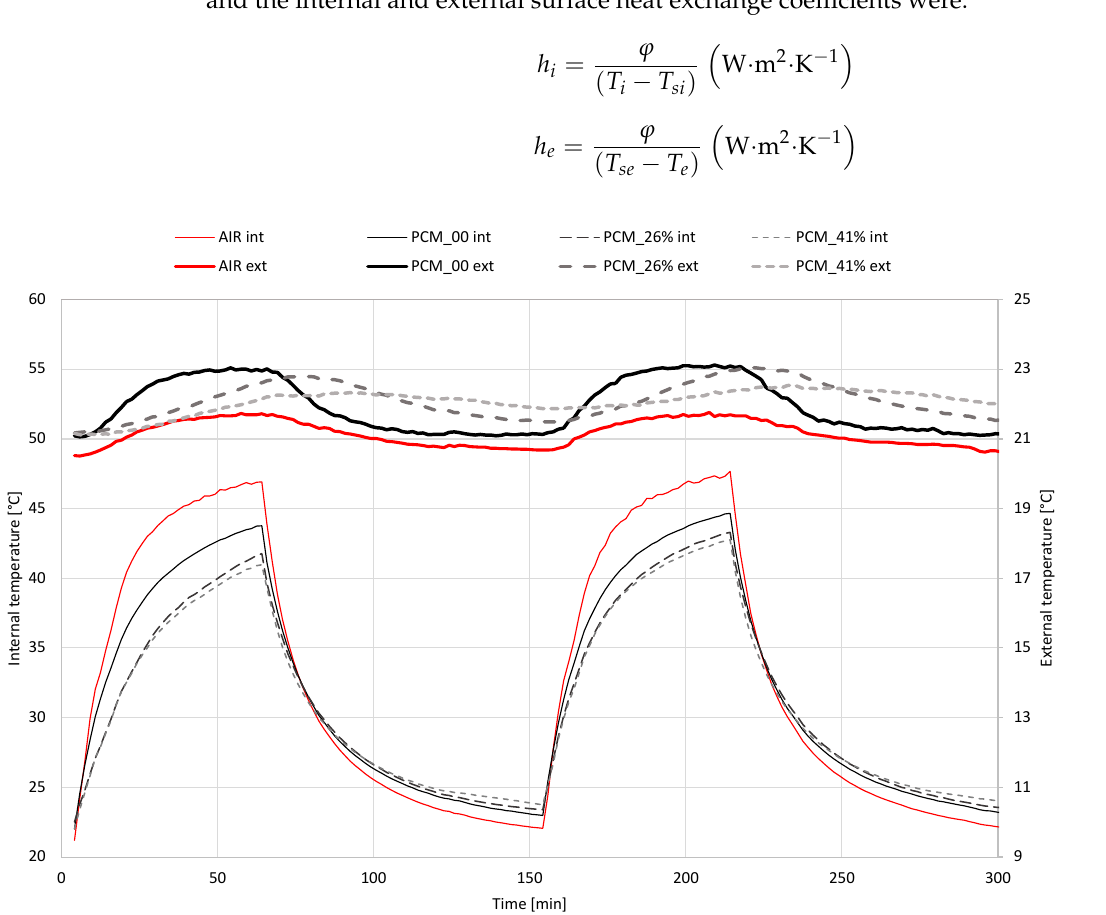
Figure 11. Air and surface temperatures in the Hot Box: Internal side (bottom) and external side (top). The mean values were 2.8 W · m − 2 · K − 1 for h i , and 7.6 W · m − 2 · K − 1 for h e (Figure 12). The lower value for the coefficient on the internal side was due to the negligible contribution of the exchange by radiation, since the internal surfaces of the Hot Box are practically isothermal. The value of h i is very close to that which can be calculated with the ASHRAE formula [38] for natural convection heat flux between a heated or cooled wall panel surface and indoor air, for vertical surface with height H = 0.53 m: